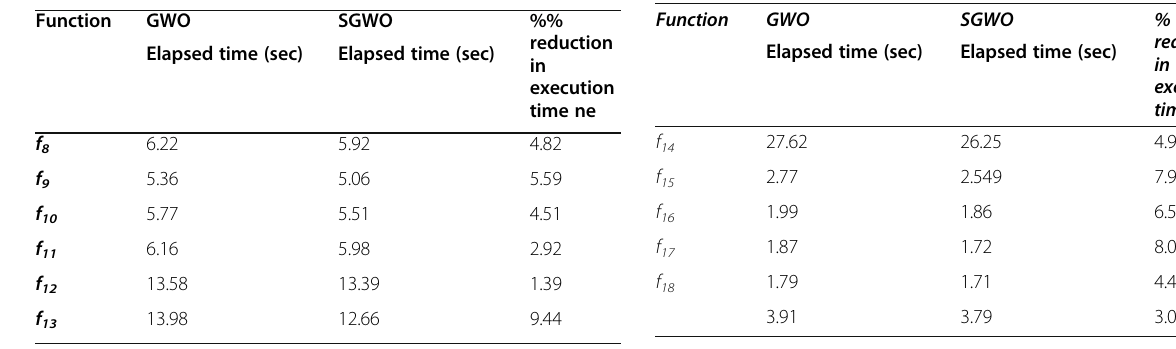
Table 6 Comparison of computational time between GWO and SGWO for fixed-dimension test functions